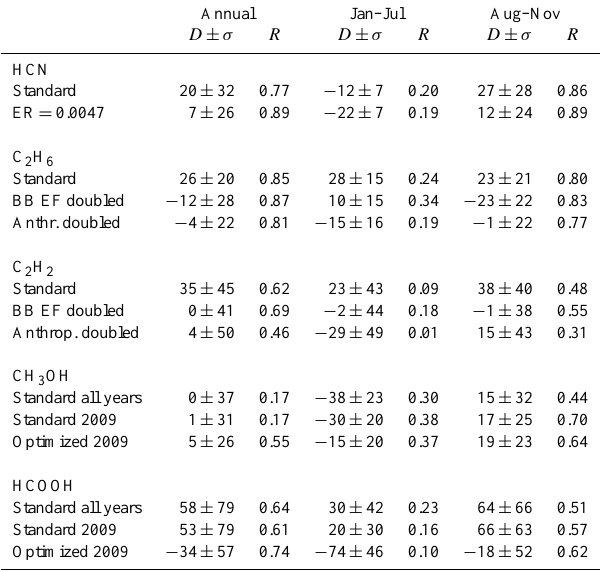
Table 5. Relative (%) mean differences ( D ) between FTIR and model total columns, mean(FTIR-model) / mean(FTIR), and stan- dard deviations ( σ ), std(FTIR-model) / mean(FTIR) for the different species and the different sensitivity tests, together with the correla- tion coefficients R . The model total columns have been smoothed to the FTIR vertical resolution using Eq.